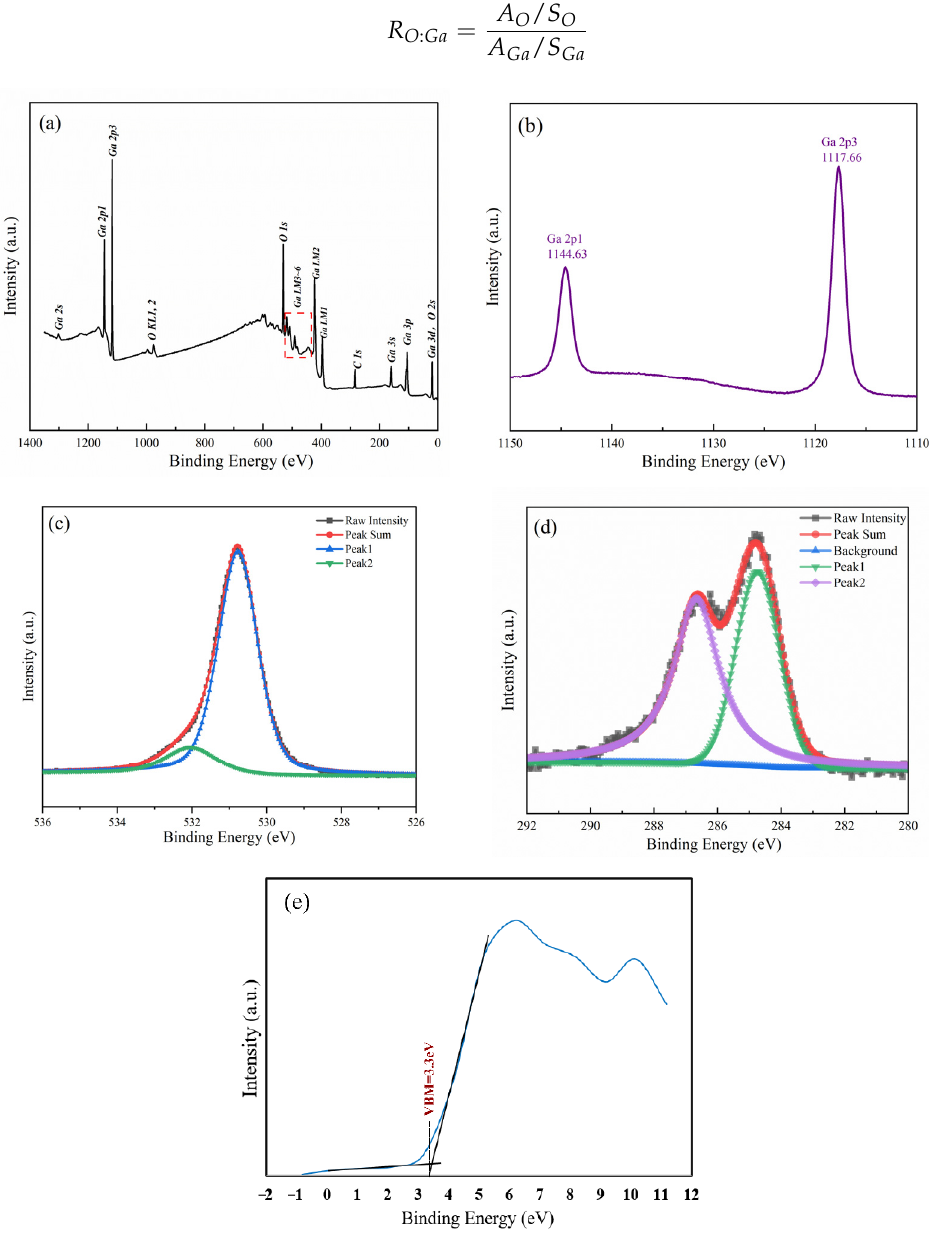
Figure 4. XPS spectra of the film. ( a ) general scan; ( b ) Ga2p core level; ( c ) raw and fitting spectra of O1s core levels; ( d ) raw and fitting spectra of C1s core levels; ( e ) valence band edge spectrum.